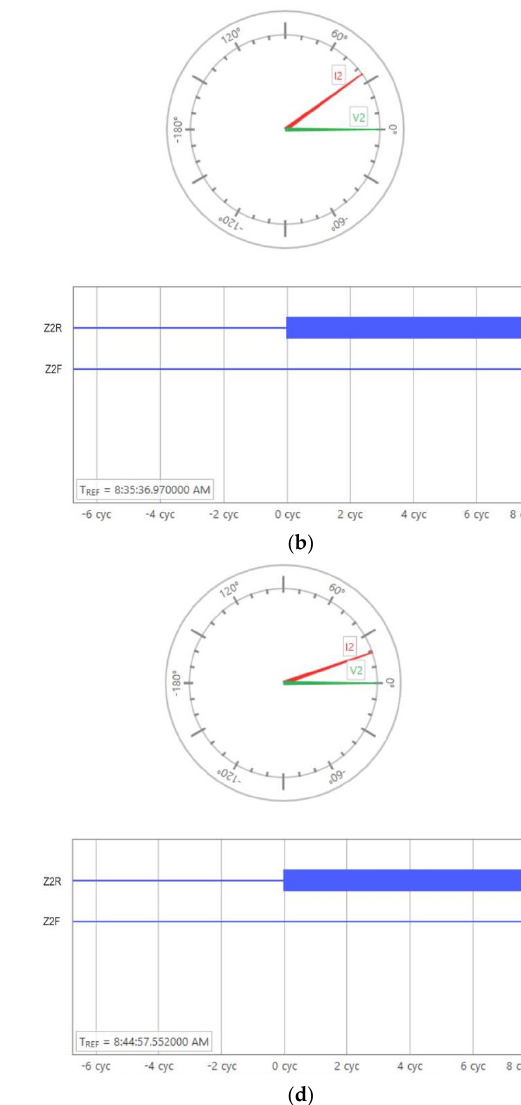
Figure 14. The oscillography data of negative-sequence current and voltage phasors and relay trip signal for 67Q element measured at the POC bus in solar PV system II under weak grid conditions following different types of faults at the grid: ( a ) three-phase fault; ( b ) single line-to-ground fault; ( c ) double line-to-ground fault; and ( d ) line-to-line fault.